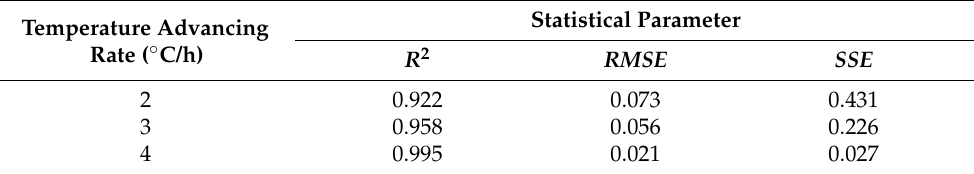
Table 1. Statistical analysis results of the moisture diffusion